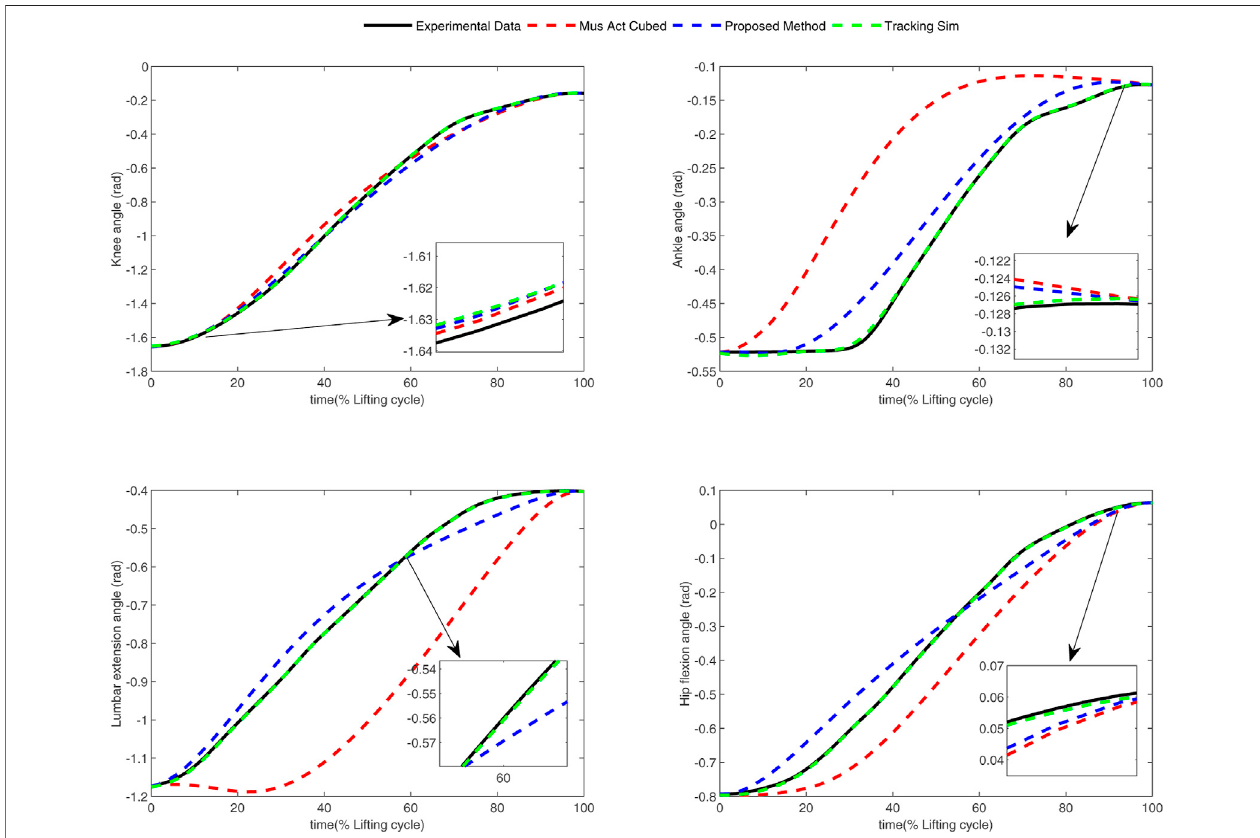
FIGURE 5 | Kinematics results of different joints obtained by different methods for subject